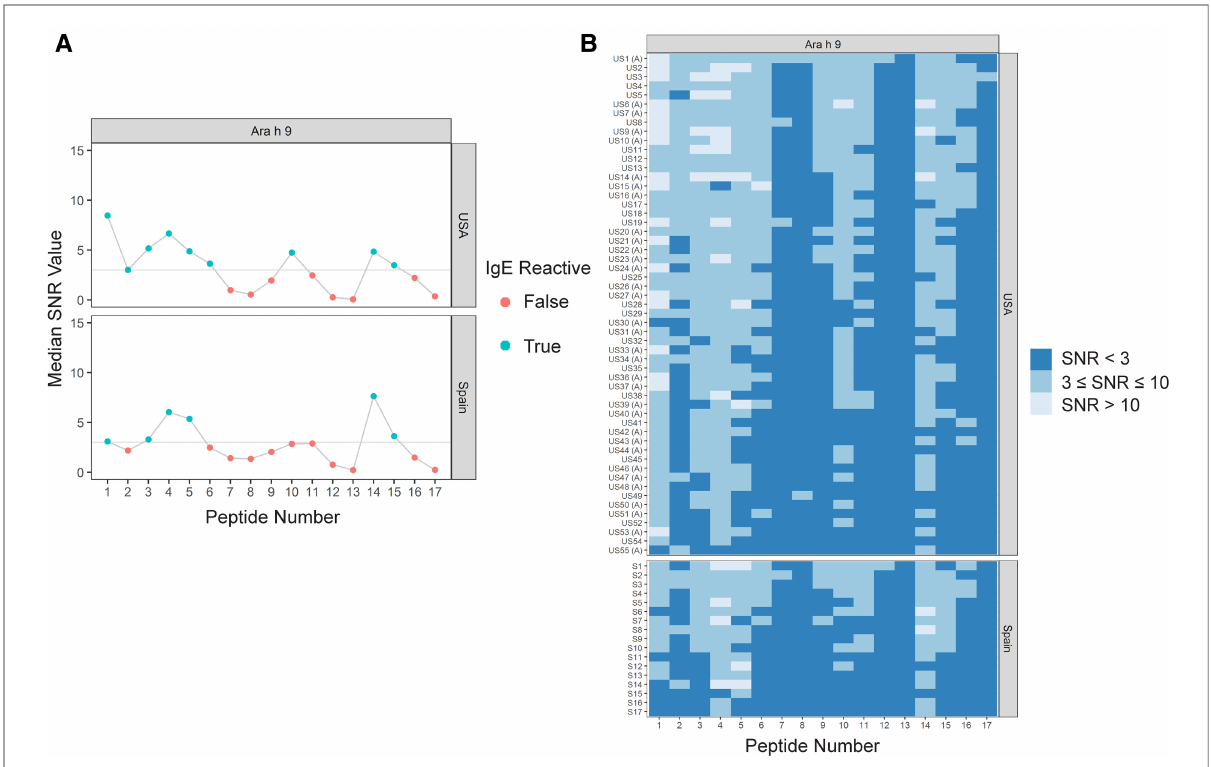
FIGURE 1 IgE binding to Ara h 9 by peptide and region (USA vs. Spain). ( A ) Dot plots representing the median SNR values for each peptide. Dots are colored blue (True) if the peptide is a major IgE reactive peptide ( ≥ 50% of the subjects have positive IgE binding) and pink (False) otherwise. The horizontal line represents the de fi nition for positive binding: SNR ≥ 3. ( B ) Heat maps representing the subject-speci fi c IgE intensities, which are categorized and displayed as follows: SNR<3 (dark blue), SNR ≥ 3 and ≤ 10 (medium blue), SNR>10 (light blue). US samples depicted with ( A ) represent sera samples provided by Aimmune Therapeutics.